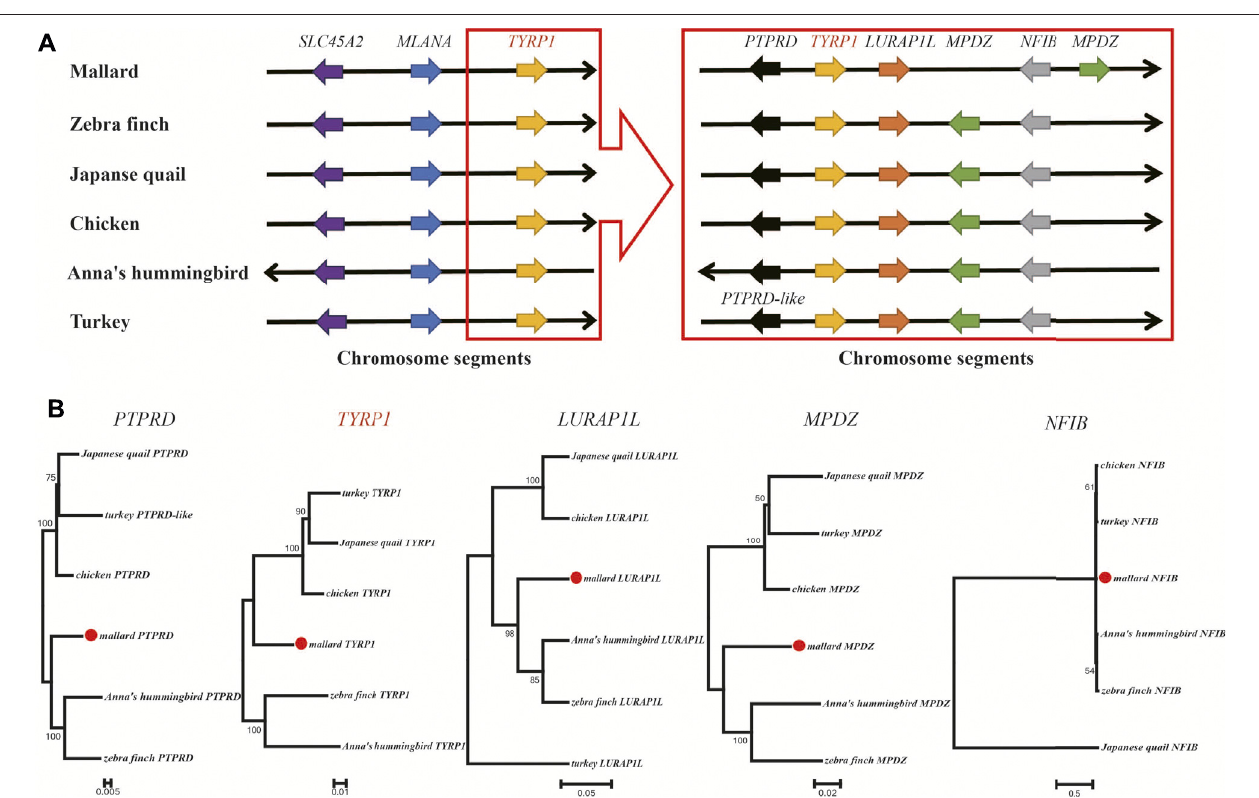
FIGURE 6 | Synteny and phylogenetic analysis of TYRP1 and its neighboring genes in avians. (A) The relative positions of pigmentation genes and the adjacent genes of TYRP1 in Z-chromosome segments. Each arrow color represents a gene. We arranged the order of the arrows based on the relative gene positions on the chromosome. (B) Phylogenetic trees of fi ve neighboring genes of the TYRP1